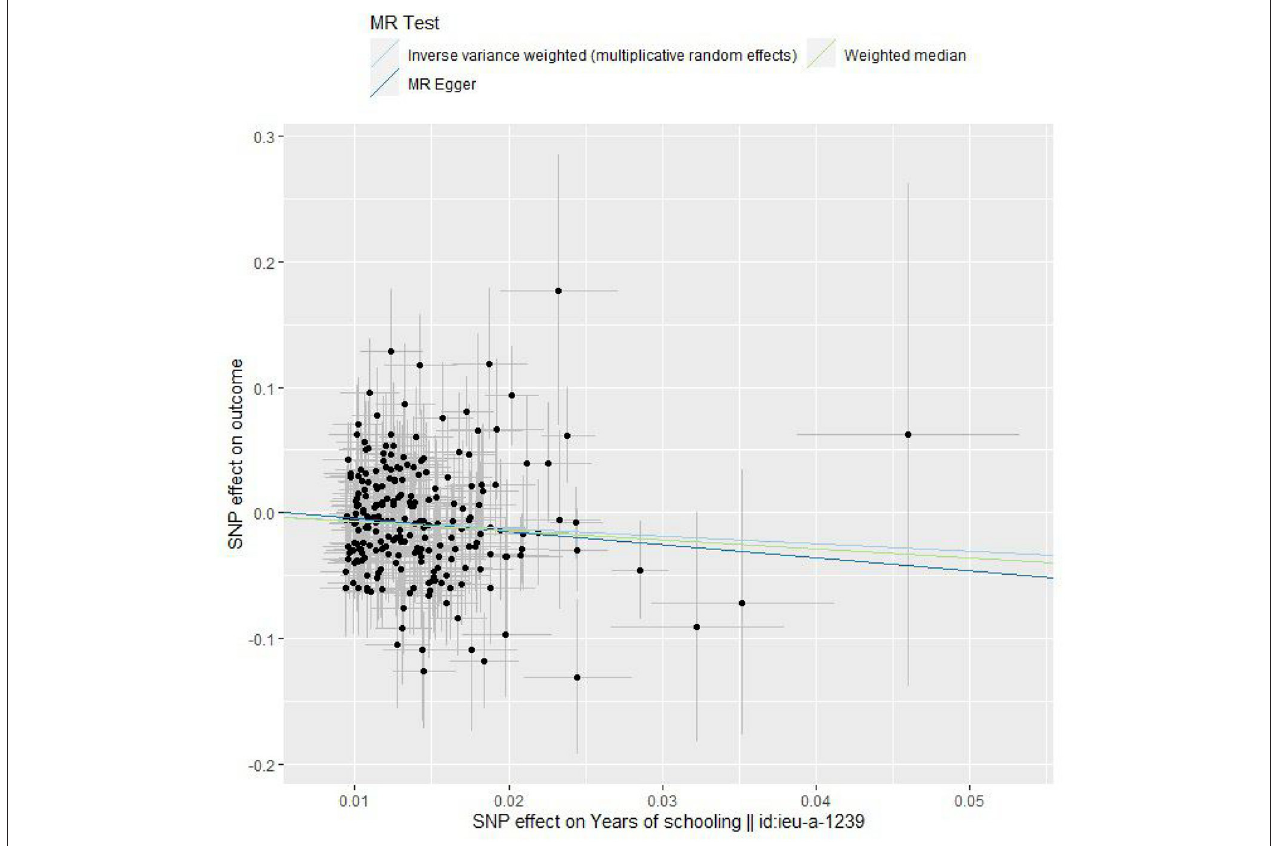
FIGURE 1 | Scatter plots. Each black point representing an SNP is plotted in relation to the effect size of the SNP on years of schooling (x-axis) and on the risk of COVID-19 severity (y-axis) with corresponding standard error bars. The slope of each line corresponds to the causal estimate using inverse variance weighted (light blue), weighted median (green), and MR-Egger regression (blue)